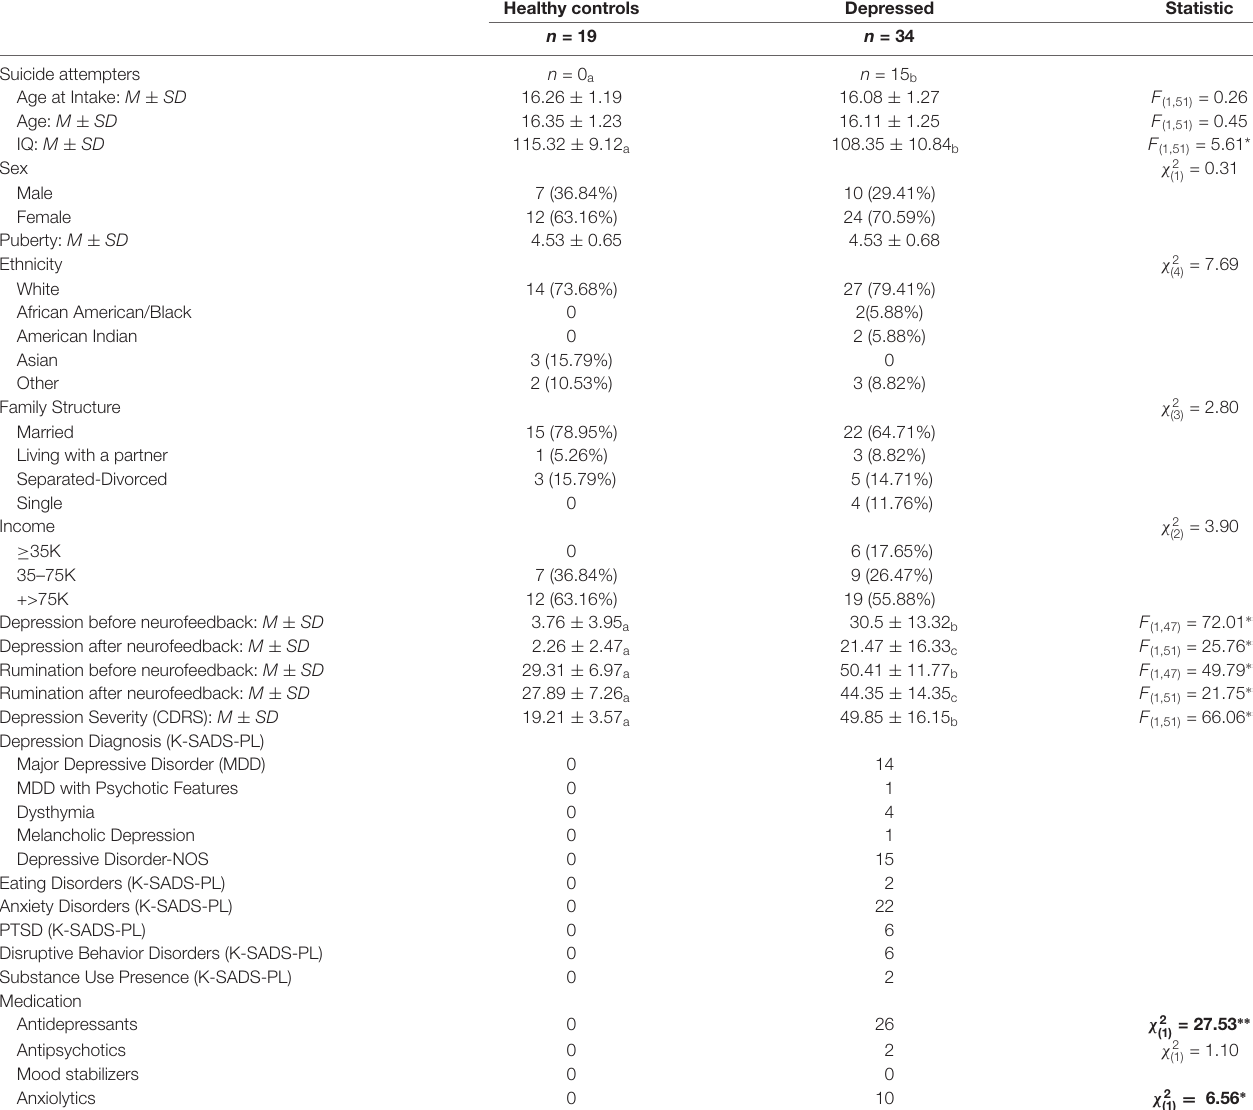
TABLE 1 | Demographics and clinical presentation by diagnostic group.